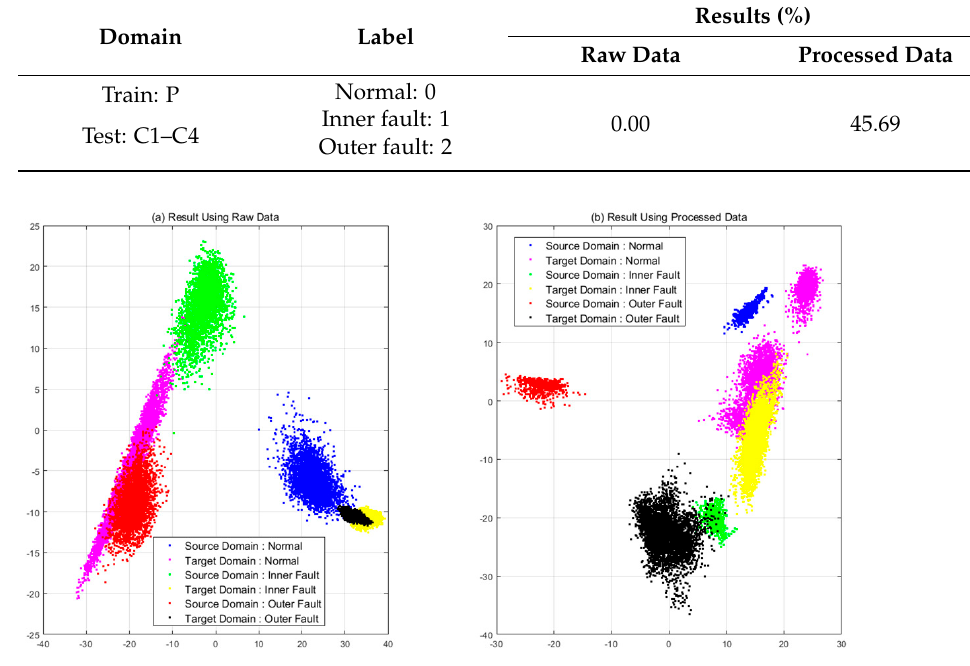
Figure 10. Comparison of features extracted from a model in case 1: ( a ) raw data ( b ) processed data.